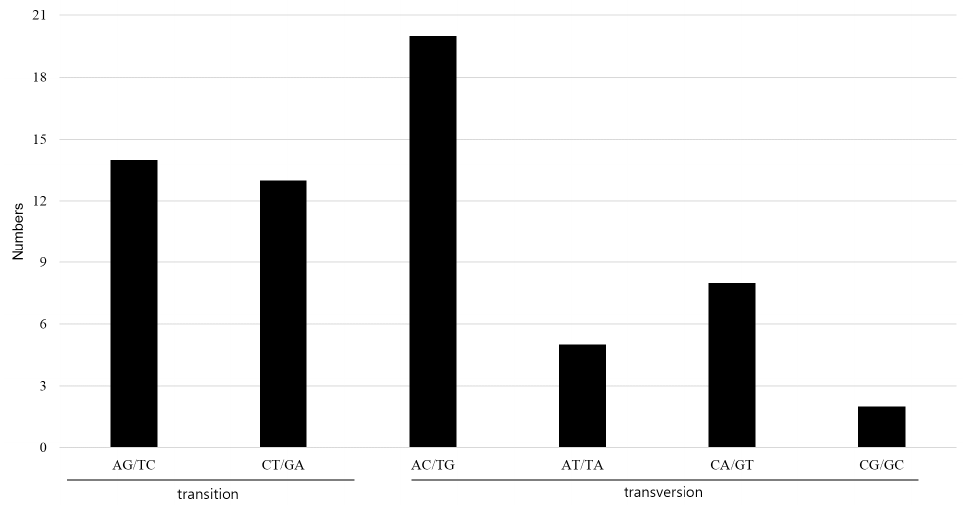
Figure 6. The nucleotide substitution pattern in A. pseudolaeve Nakai and A. longecassidatum Nakai CP genomes. The patterns were divided into six types, as indicated by the six non-strand-specific base- substitution types (i.e., numbers of considered G to A and C to T site sites for each respective set of associated mutation types). The A. pseudolaeve chloroplast genome was used as a reference. CP: